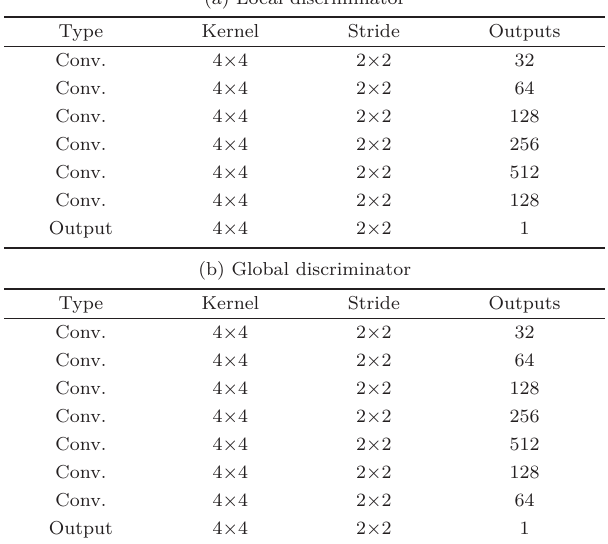
Table 3 Discriminator architectures. All Conv. layers are followed by leaky ReLU activation (slope 0 . 2). The output layer consists of